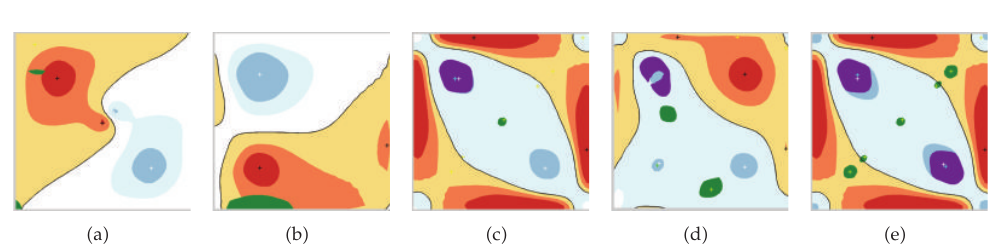
Figure 18: Field visualization.